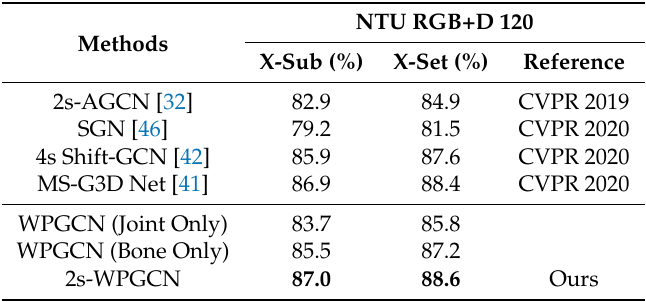
Table 6. Recognition accuracy comparison against state-of-the-art methods on the NTU RGB+D 120 dataset. The best results are shown in bold.